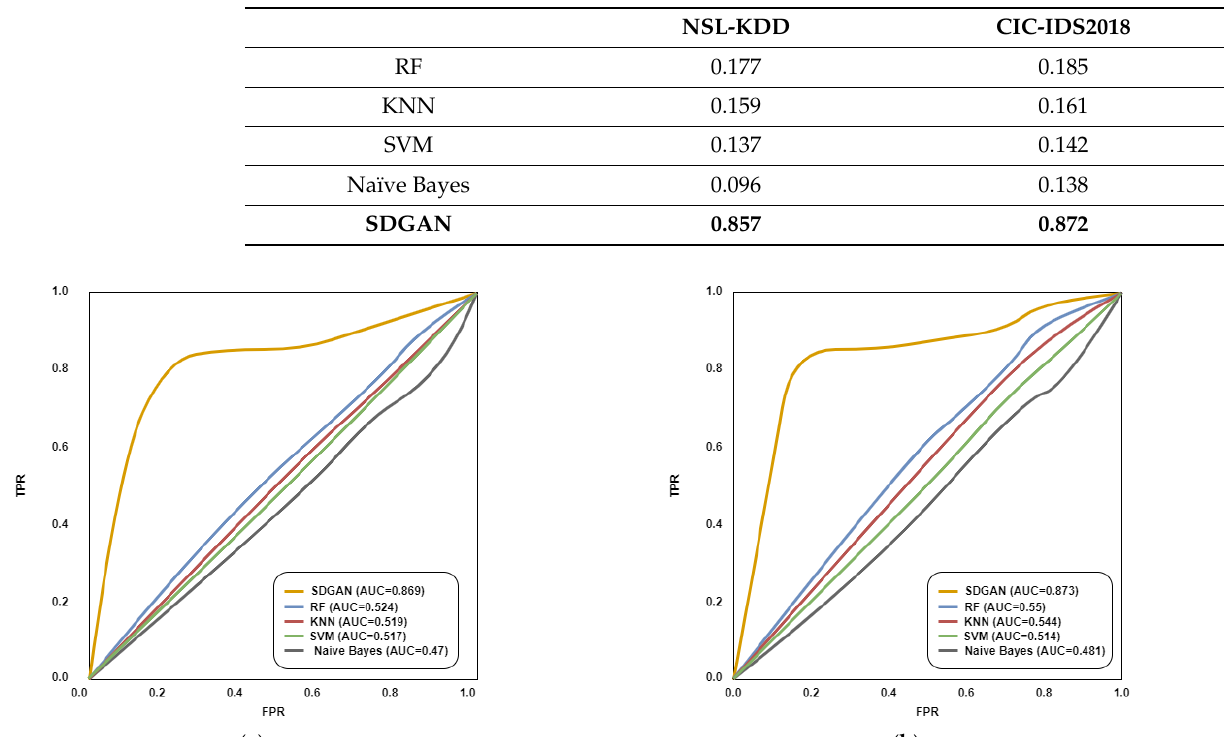
Figure 7. ROC curves of ML-based defense DDoS detection and SDGAN on adversarial DDoS attacks: ( a ) NSL-KDD; ( b ) CIC-IDS2018.